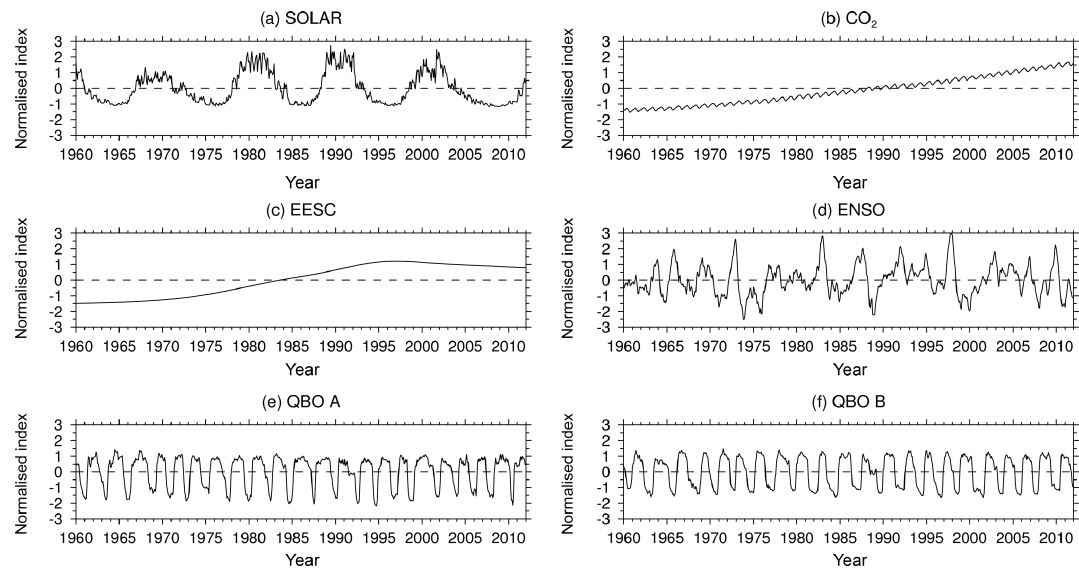
Figure 1. Time series of the six basis functions used in the MLR analysis. (a) Solar forcing based on F10.7cm flux; (b) CO 2 ; (c) equivalent effective stratospheric chlorine; (d) ENSO index; (e, f) two orthogonal QBO indices defined as the first two principal component time series of tropical zonal mean zonal winds (in this case taken from observations). The time series are in units of standard